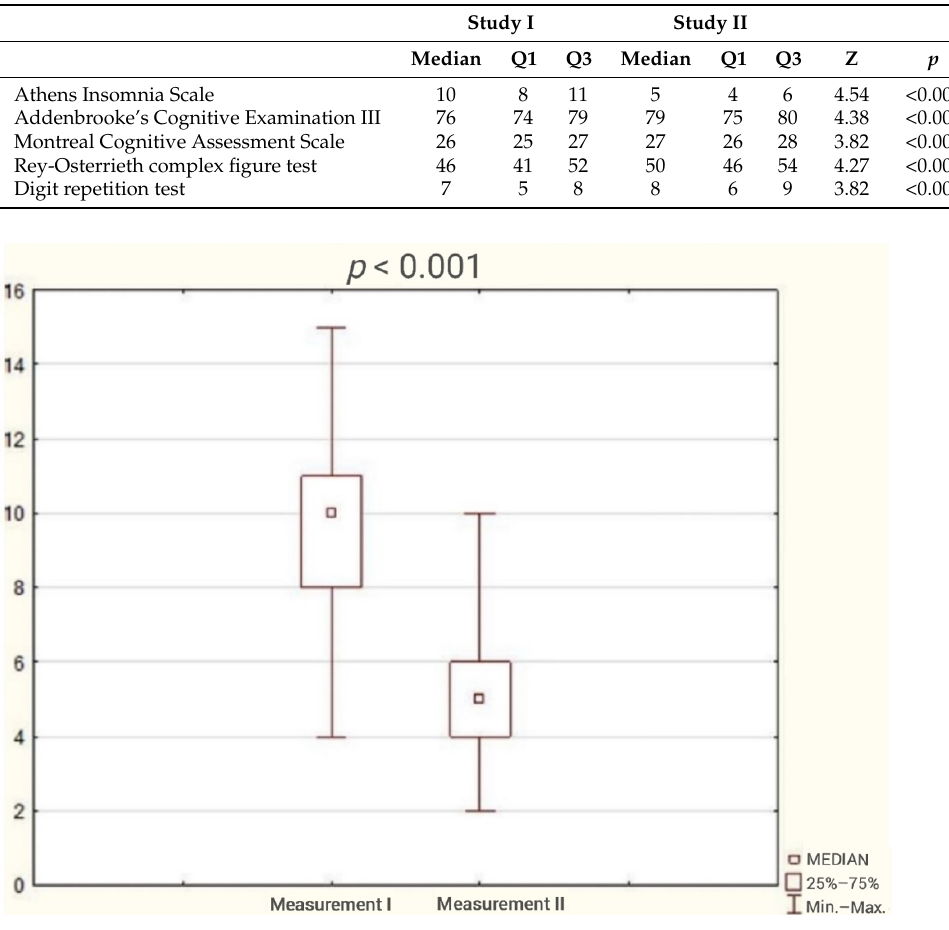
Figure 2. Patient result in Athens Insomnia Scale (AIS) during the first and second study (Wilcoxon test).